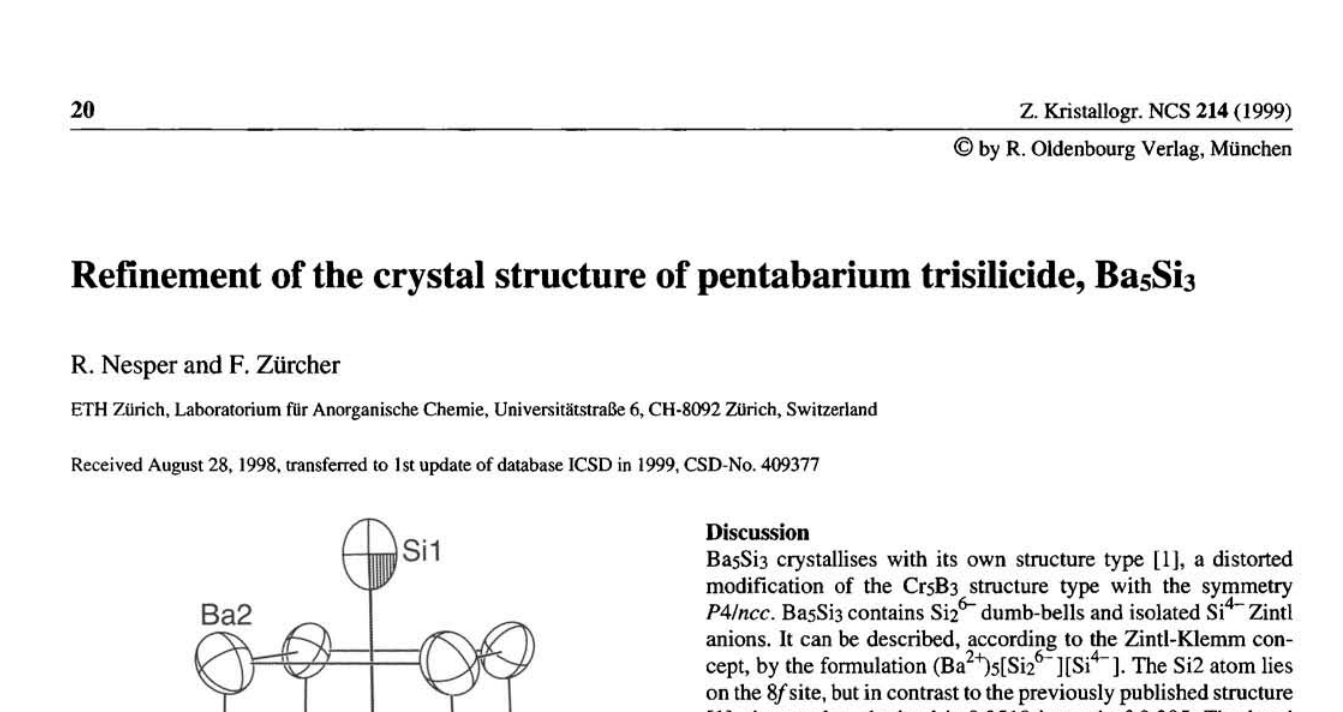
Table 1. Data collection and handling.